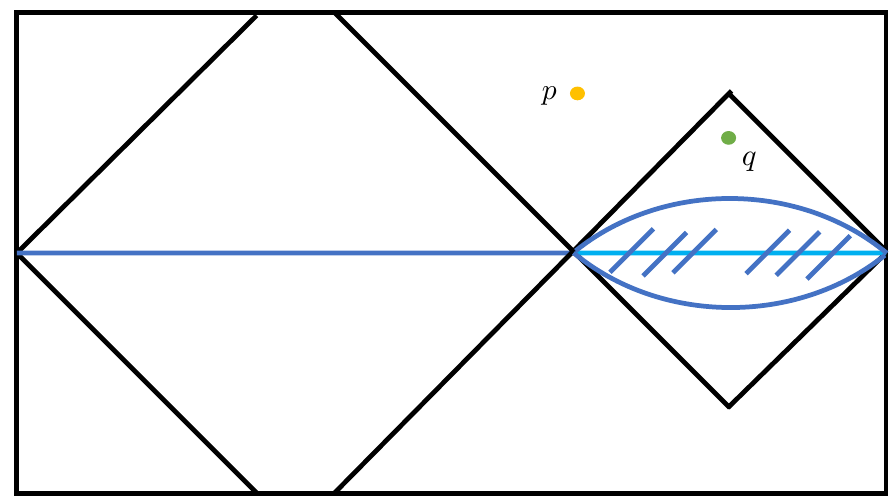
Figure 4 . The regions D [ R ] and D [ (cid:22) R ] for an asymmetric division of the system in the case of a boundary dS 2 spacetime, whose Penrose diagram we depict here. The region E [ R ] for R the smaller subregion is indicated by the dark blue hatchmarks. Operators at the point p can be causally in(cid:13)uenced from either region and are not in EW[R] or EW[ (cid:22) R ]; this is familiar in asymptotic AdS/CFT. The point q illustrates a point in D [ R ] which is not in E [ R ]. Operators at that point do not commute with those in the algebra (cid:22) R s corresponding to the complementary subsystem to A R . We note that this point q on the boundary is also not part of the EW of either R or (cid:22) R , since it can be reached causally from